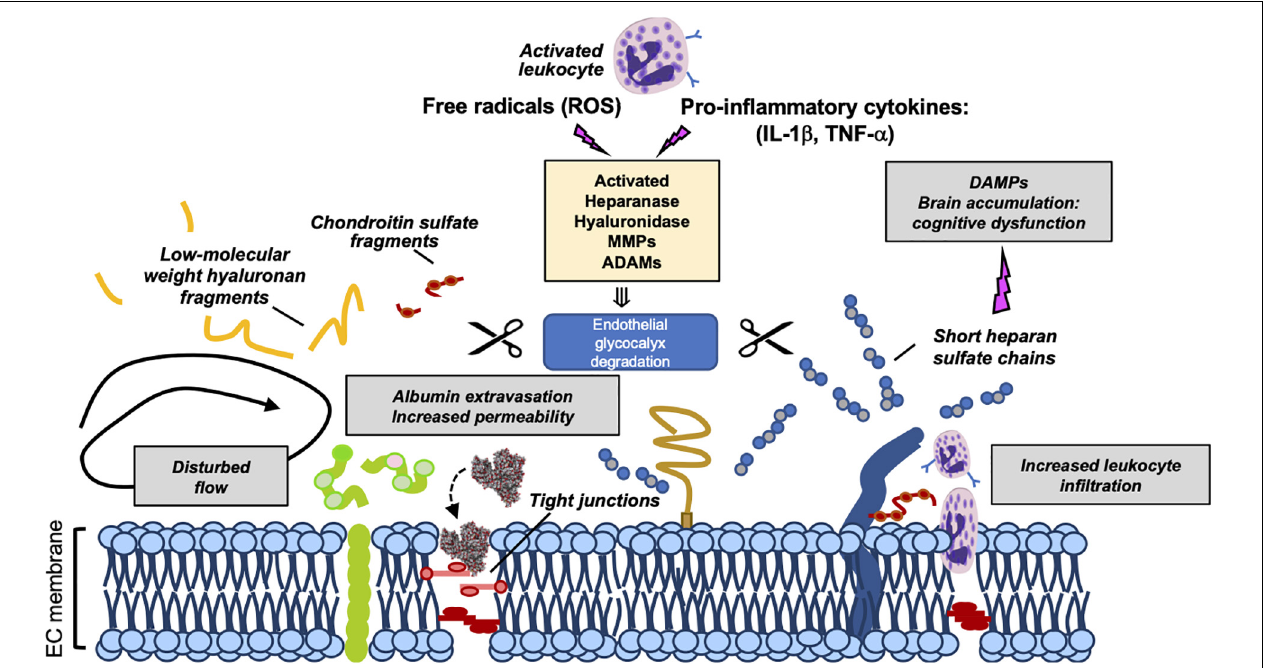
FIGURE 2 | Mechanisms of eGCX degradation and pathogenic consequences of released GCX fragments. Representation of enzymatic degradation of GCX components. The structure of the eGC is the result of a balance between the enzymatic degradation and de novo biosynthesis of new molecules and adsorption of circulating components from blood. Several enzymes mediate this degradation. Heparinase, hyaluronidase, MMPs and ADAMs are activated by pro-inflammatory cytokines and ROS promoting the damage and shedding of one or more of its components. This degradation releases eGCX components (such as short heparan sulfate chains, low-molecular weight hyaluronan fragments, and chondroitin sulfate fragments) into the circulation. As a result of its degradation, the eGC becomes thinner allowing the extravasation of albumin, leukocyte adhesion and dysregulated vasodilation. Once in circulation, eGCX components such as heparan sulfate fragments can act as DAMPs leading to cognitive impairment (Hippensteel et al., 2019a). Gray box areas summarize major pathophysiologic features of eGCX degradation. DAMPs, danger-associated molecular patterns; MMP, metalloproteinase; IL-1 β , interleukin-1 β ; TNF- α , tumor necrosis factor- α . Scissors symbol means